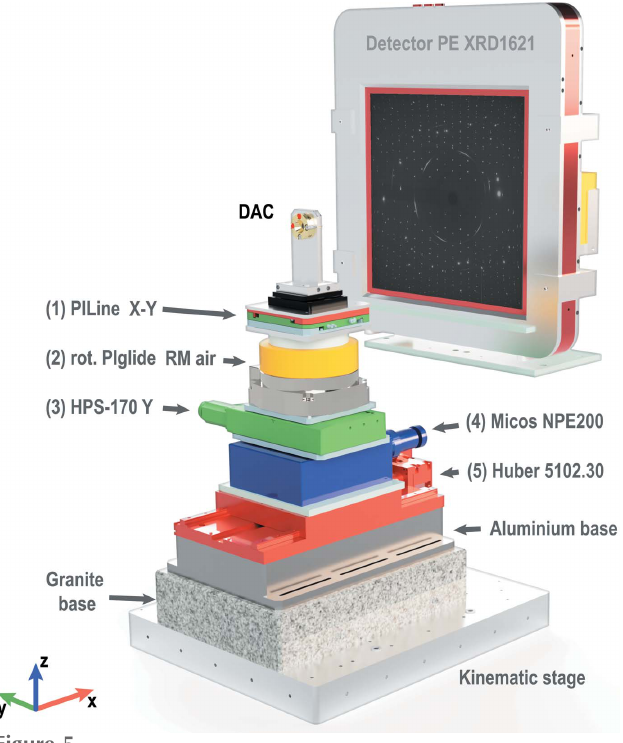
Figure 5 A schematic illustration of the sub-micrometer motor sample stack. ‘DAC’ indicates the position of a sample mounted in a DAC. For clarity, individual components are represented by different colors and are numbered. The corresponding coordinate system employed at the beamline is shown at the bottom of the figure. The x axis is collinear to the X-ray beam direction. The Perkin–Elmer XRD1621 detector is shown for